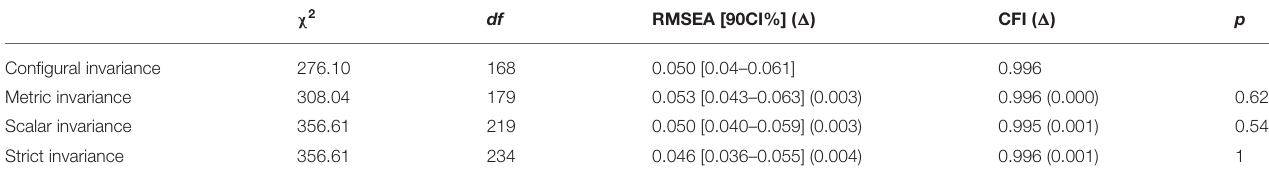
TABLE 2 | Multiple-group confirmatory factor analysis models for measurement and structure invariance across gender.